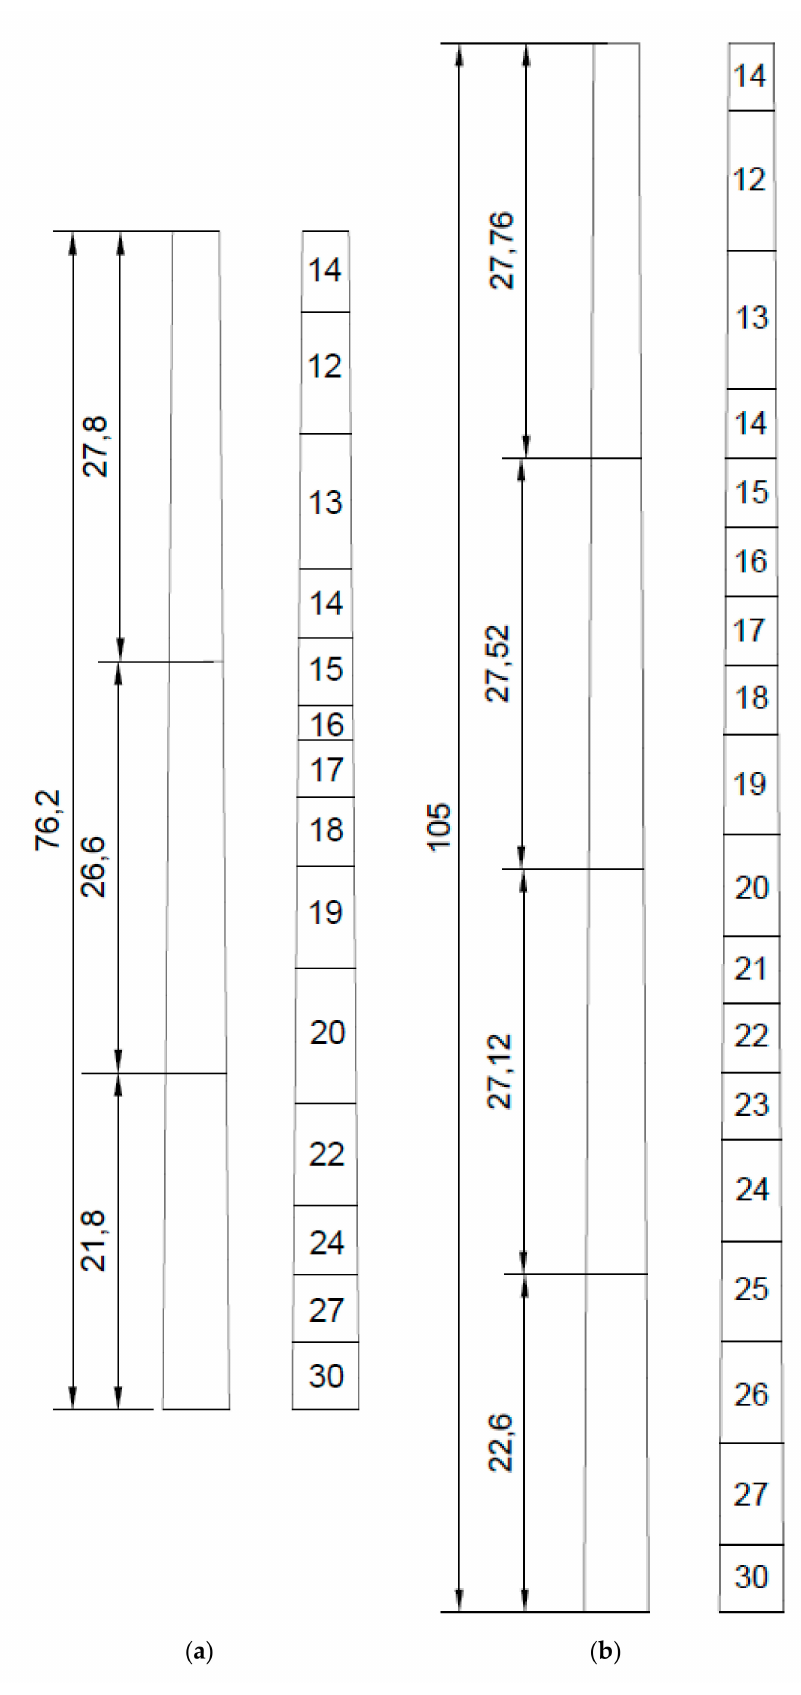
Figure 1. Tubular tower configurations: ( a ) Tower_T_A shell thickness distribution; ( b ) Tower_T_B shell thickness